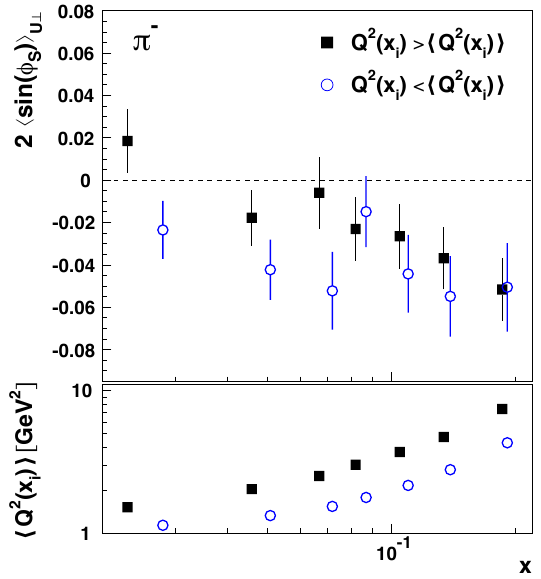
CSA amplitudes for π − as a function of x . The Q 2 region for each Figure 27 . The 2 h sin( φ S ) i h U ⊥ bin was divided into the two regions above (squares) and below (circles) the average Q 2 of that bin. The average Q 2 is given in the bottom for all bins separately for the two Q 2 regions. The error bars represent statistical uncertainties